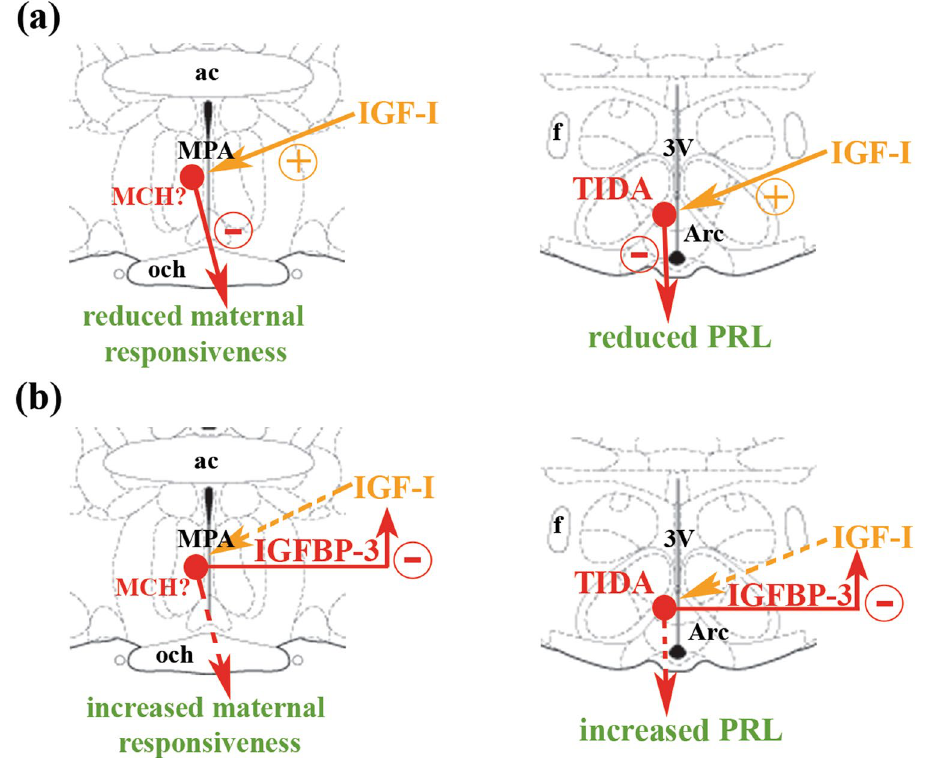
Figure 8. A model showing how the IGF-I - IGFBP-3 system regulates maternal responsiveness and prolactin release. ( a ) In virgin females and pup-deprived mothers, IGF-I of hypothalamic origin or from the circulation probably induce the expression of MCH in the preoptic area and enhances the expression of the TH enzyme, furthermore stimulates its activation by phosphorylation in TIDA neurons. Consequently, these cells produce more MCH or dopamine, which inhibits maternal responsiveness or prolactin secretion from the pituitary. ( b ) In lactating mothers, MCH and TIDA neurons enhance the expression of IGFBP-3, which can neutralize IGF-I. The MCH or TIDA stimulating effect induced by IGF-I diminishes, which results in a decrease in MCH or dopamine production and concomitant increased maternal responsiveness or prolactin secretion due to its release from tonic inhibition. Abbreviations: ac – anterior commissure, Arc – arcuate nucleus, f – fornix, MPA – medial preoptic area, och – optic chiasm, 3 V – third